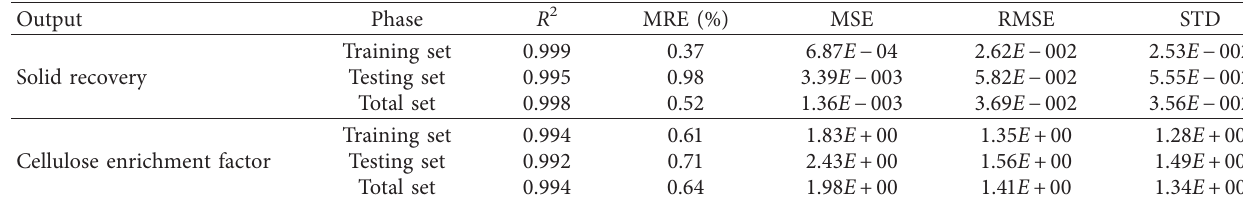
Table 1: Various statistical analyses to evaluate the proposed